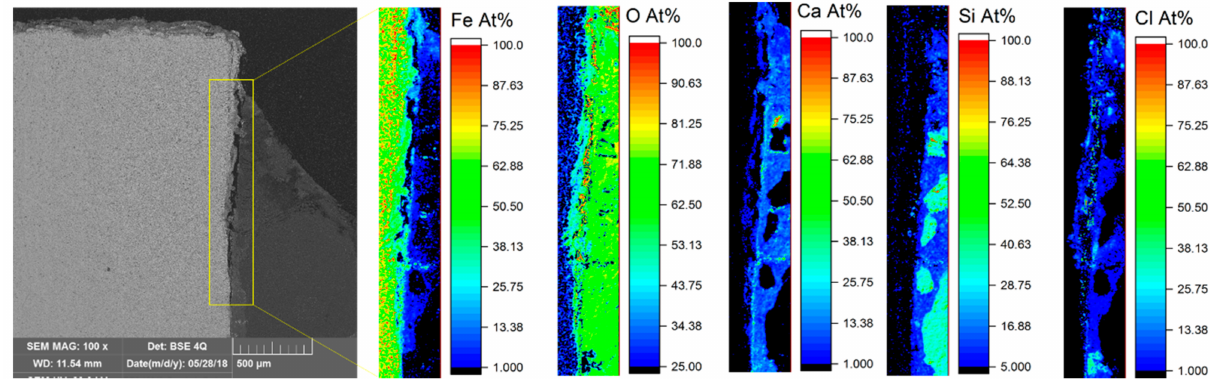
Figure 12. EDS element mapping at the 1.7225/Variodur interface after 20 weeks of exposure to aquifer fluid under 10 MPa CO 2 .